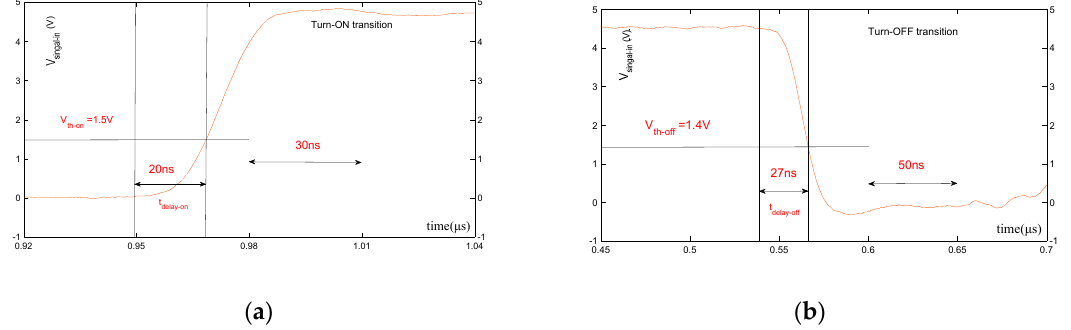
Figure 7. Input signal of driver without C X . ( a ) Turn-on transient; ( b ) Turn-on transient.